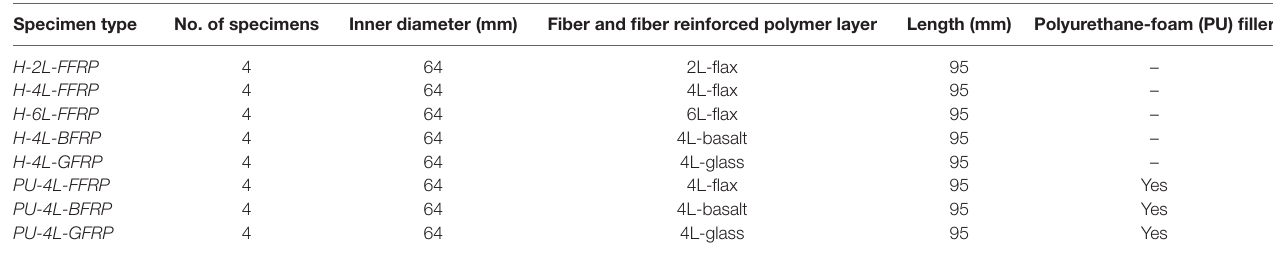
TaBle 1 | Test matrix of the composite